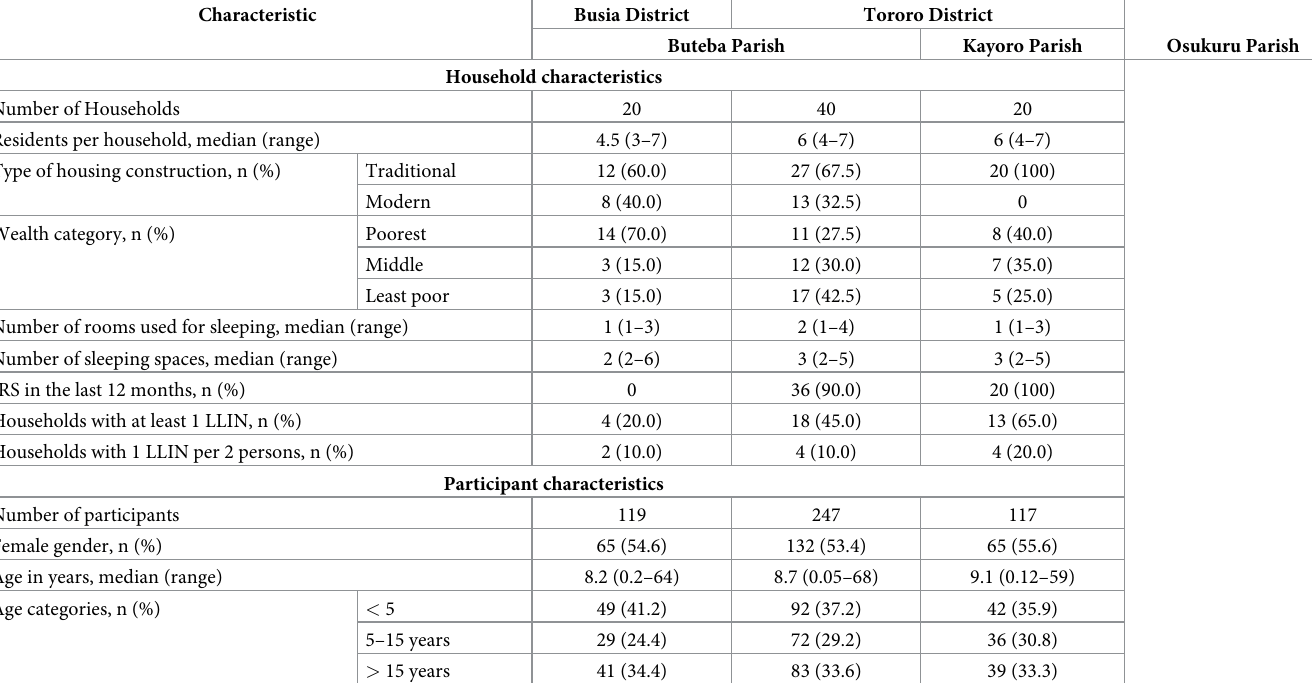
Table 1. Characteristics of households and cohort participants at enrolment.